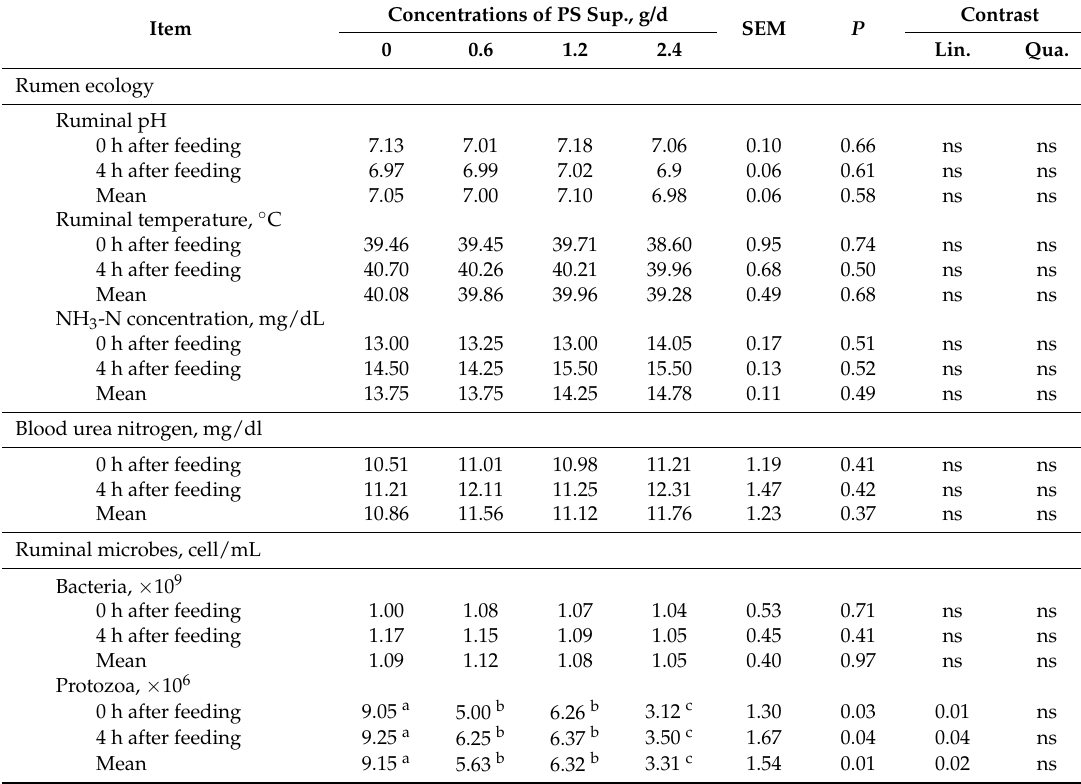
Table 3. Effect of supplementation of Piper sarmentosum (PS) leaf meal on ruminal fermentation, rumen microorganisms and blood